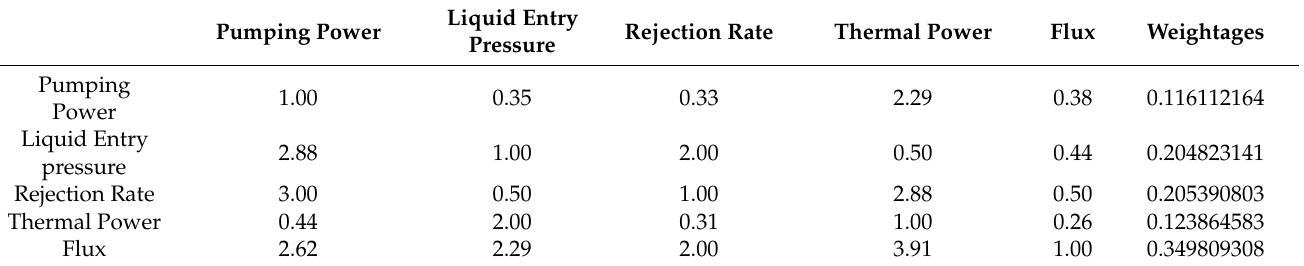
Table 5. Synthesized results of derivable outputs of MD using AHP-MDM.